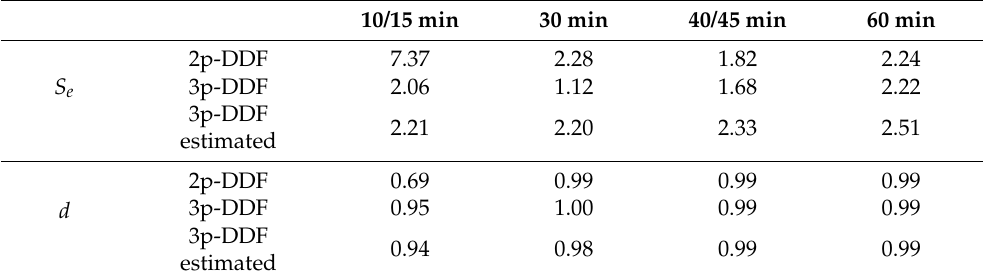
Table 2. Standard error of estimate ( S e ) and index of agreement ( d ) of 2p-DDF, 3p-DDF, and 3p-DDF estimated curves in estimating the rainfall depth from Gumbel